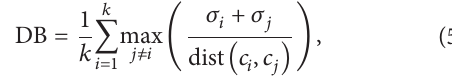
Figure 3: Process of